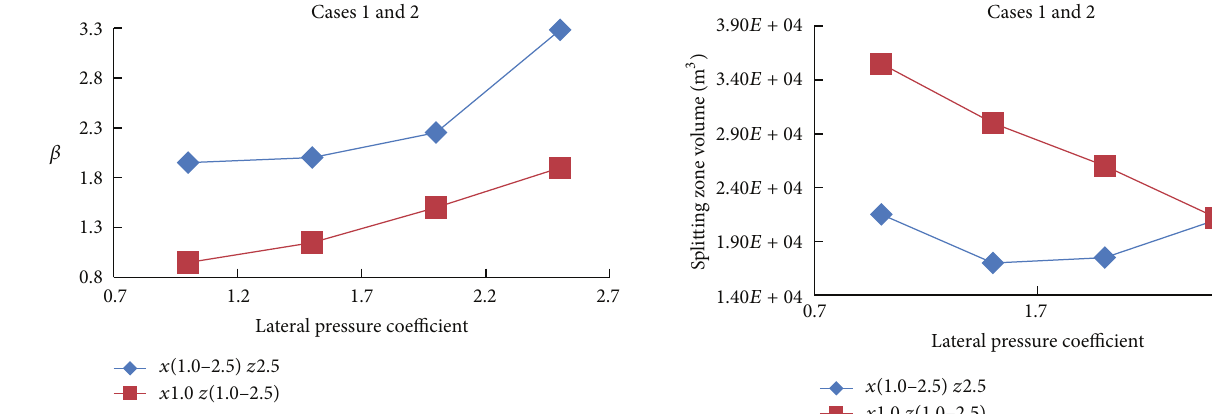
Figure 19: 𝛽 versus lateral pressure coefficient in cases 1 and 2 .